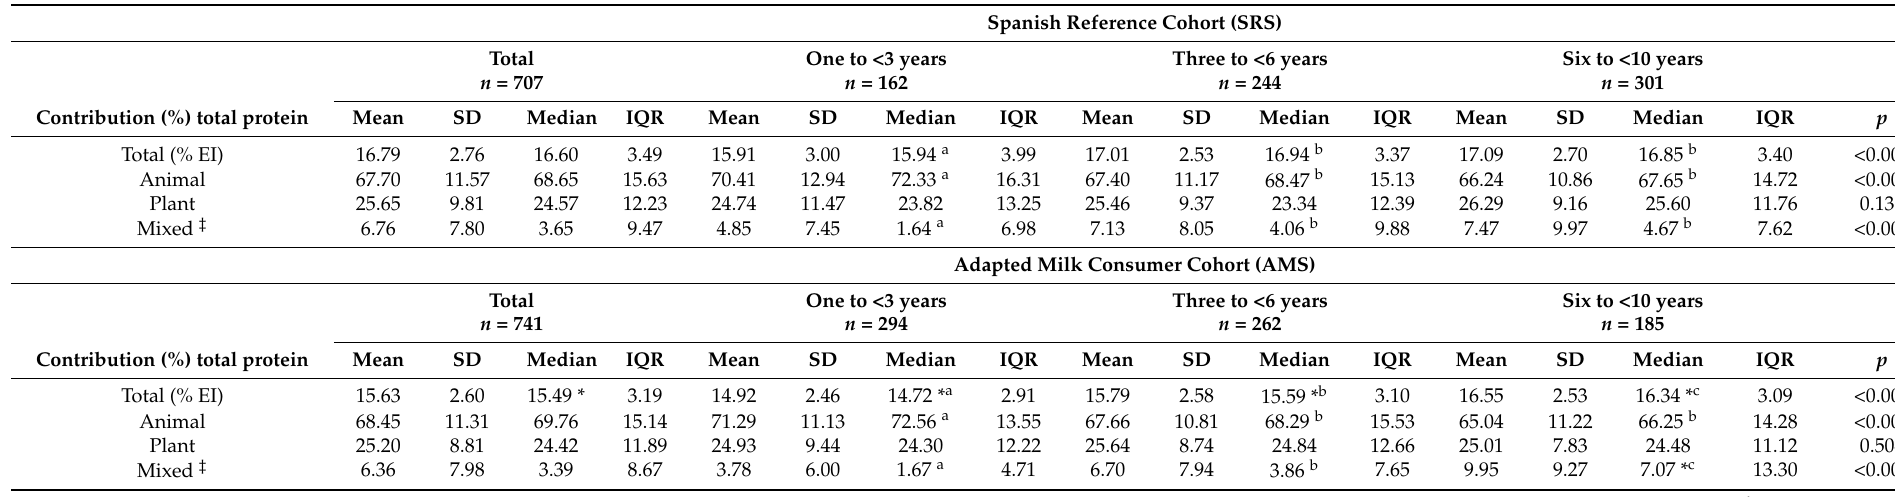
Table 3. Percentage of contribution of total protein and animal and plant protein intakes to the total energy intake based on two 24-h DRs of two cohorts of the Nutritional Study in the Spanish Pediatric Population (EsNuPI), according to age group ( n =